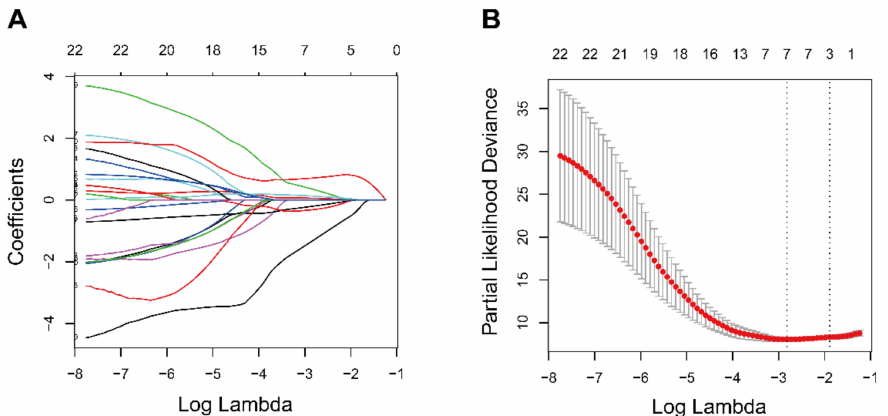
Figure 2. Prognostic gene signature construction using he least absolute shrinkage and selection operator Cox regression model (LASSO). ( A ) Distribution of LASSO coefficients of the 22 ferroptosis- related potential prognostic genes in training cohort. ( B ) The generated coefficient distribution plots for the logarithmic (lambda) sequence for the selection of the best parameter